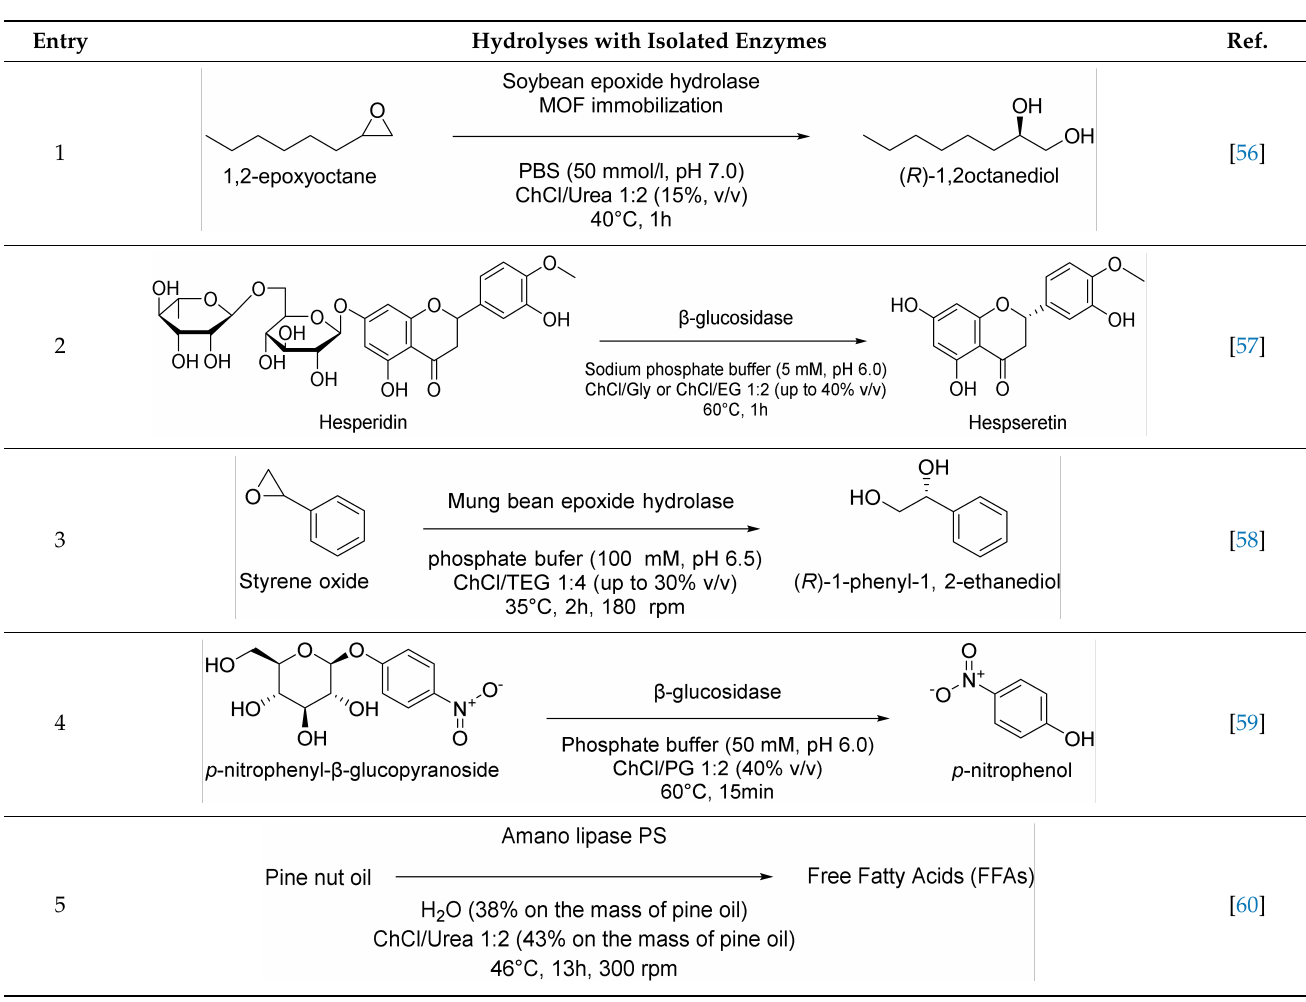
Table 5. Hydrolyses with isolated